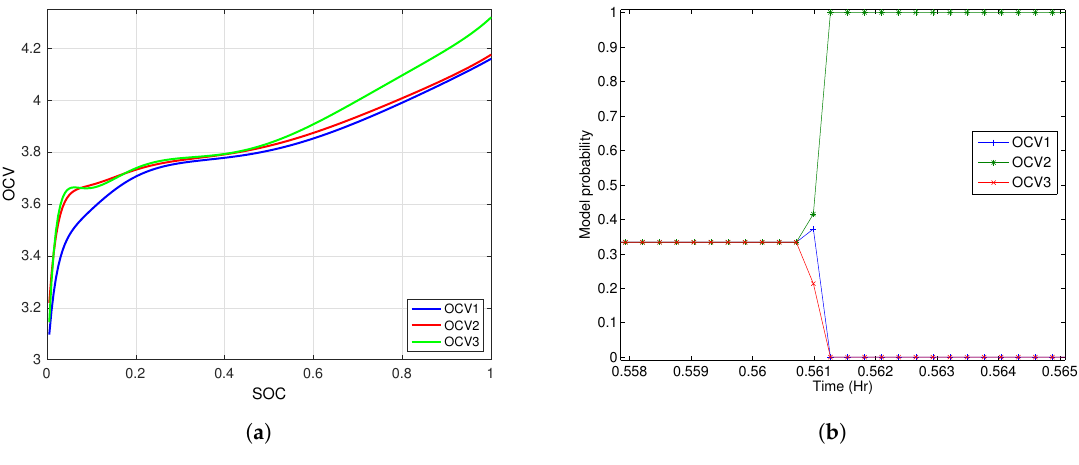
Figure 10. Chemistry adaptive BMS. The proposed chemistry probabilistically selects the battery parameters based on the measured data from the battery (voltage and current). In the above demonstration, all three models were initialized with equal probability (1/3); within few samples of measured data, the PDA algorithm was able converge to the correct model. ( a ) OCV curves of different chemistries; ( b ) Model probabilities of the PDA algorithm